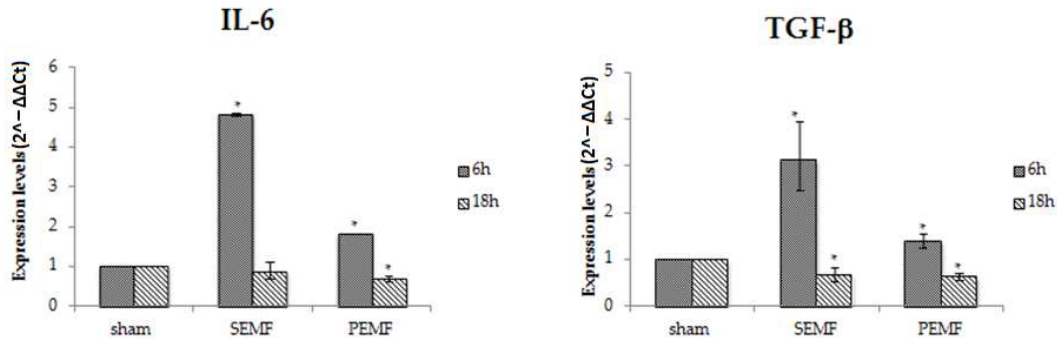
Figure 4. The mRNA expression of interleukin 6 (IL-6) and transforming growth factor beta 1 (TGF- β) in hGFs exposed to the SEMF and the PEMF compared to sham-exposed cells. Expression levels of IL-6 and TGF-β (2 −ΔΔ C t ) are reported as mean ± standard error (SE). * p -Value < 0.05 SEMF or PEMF vs. sham assumed as 1.